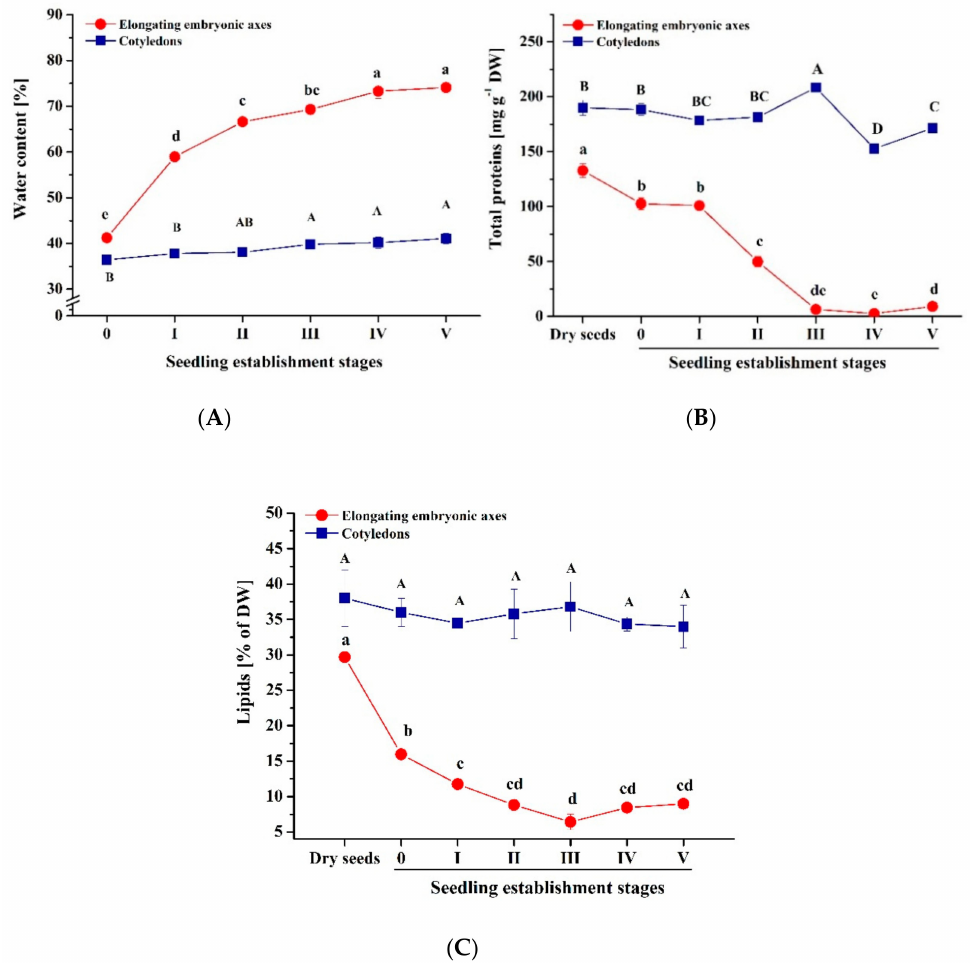
Figure 1. Changes in water status ( A ) and storage materials including proteins ( B ) and lipids ( C ) in elongating embryonic axes and cotyledons at selected seed germination and seedling establishment stages in Fagus sylvatica under normal conditions. Data shown as the means ± standard deviation obtained from three independent experiments with similar results. Statistically significant di ff erences are indicated with di ff erent letters (one-way ANOVA followed by Tukey’s test at p ≤ 0.05). The level of storage materials was measured. The total protein level halved when embryonic axes protruded to 10 mm and continued to decrease at further seedling establishment stages as the embryonic axes prolonged ( r = − 0.74443, p = 0.1689). Changes in the protein levels of cotyledons were less pronounced (Figure 1B). Lipid depletion was monitored quantitatively (Figure 1C). Initially, lipids in cotyledons and embryonic axes in dry seeds constituted 38.1% ± 4.3% and 29.6% ± 1.1%, respectively, of the dry weight. In cotyledons, the high level of lipids did not change